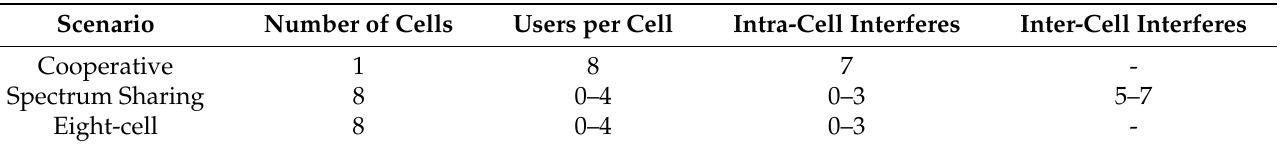
Table 2. Estimated parameters used per scenario based on different levels of cooperation. The range of values depends on the allocation of users in each